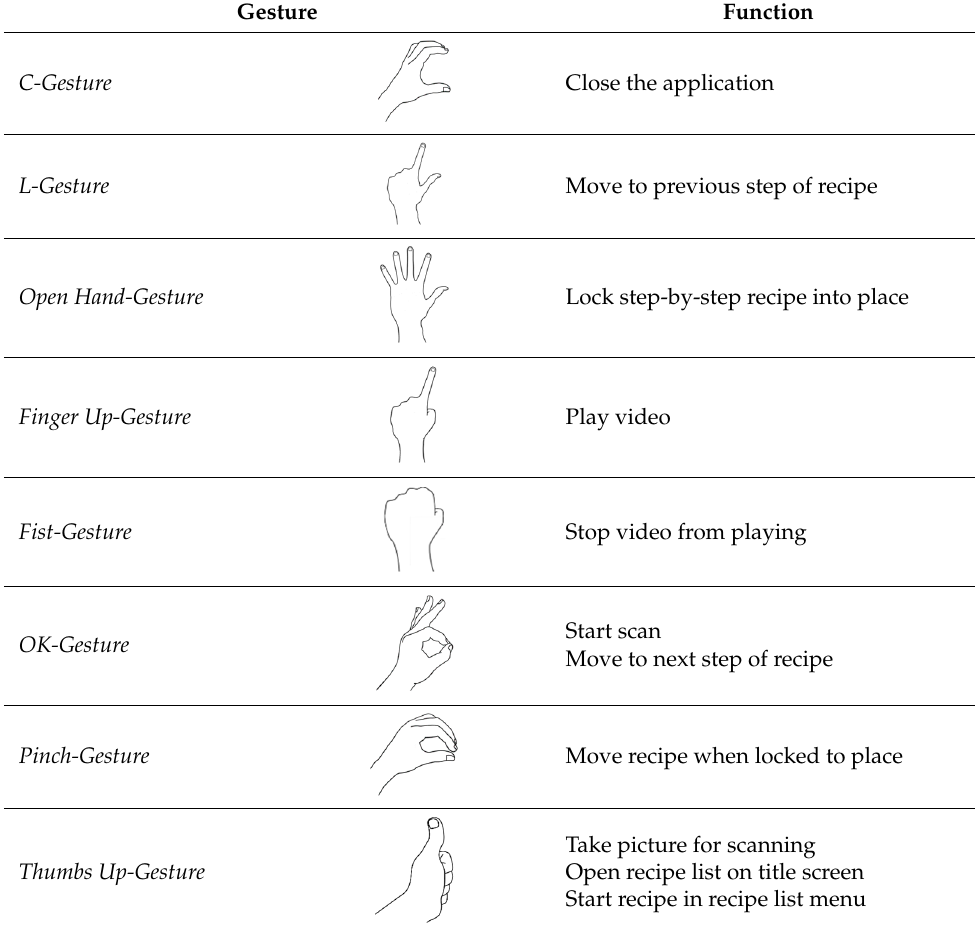
Table 2. Eight hand gestures and their